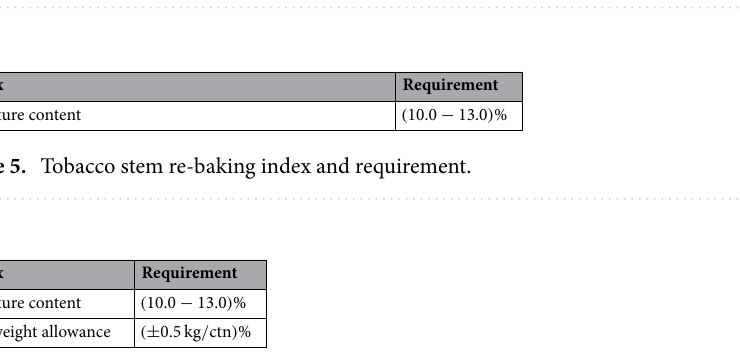
Table 4. Tobacco flakes re-baking packing index and requirement.